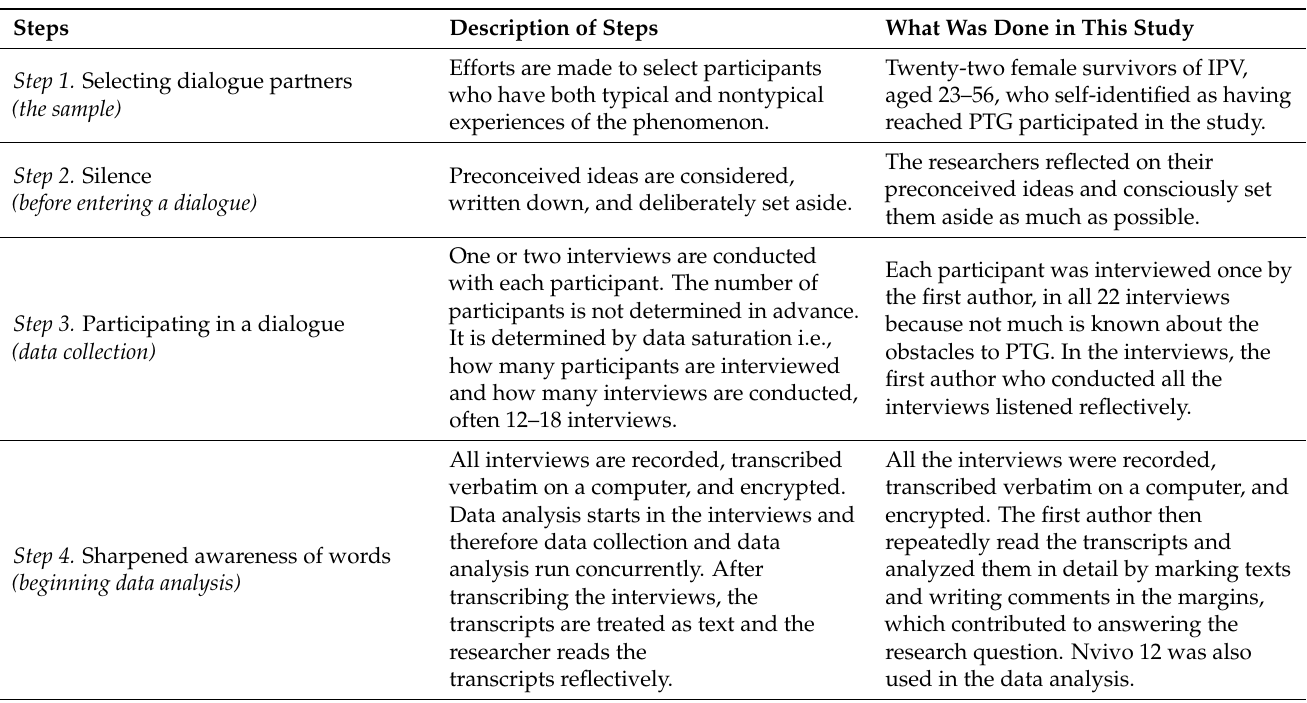
Table 2. The 12 basic research steps of the Vancouver School process and how they were followed in the present